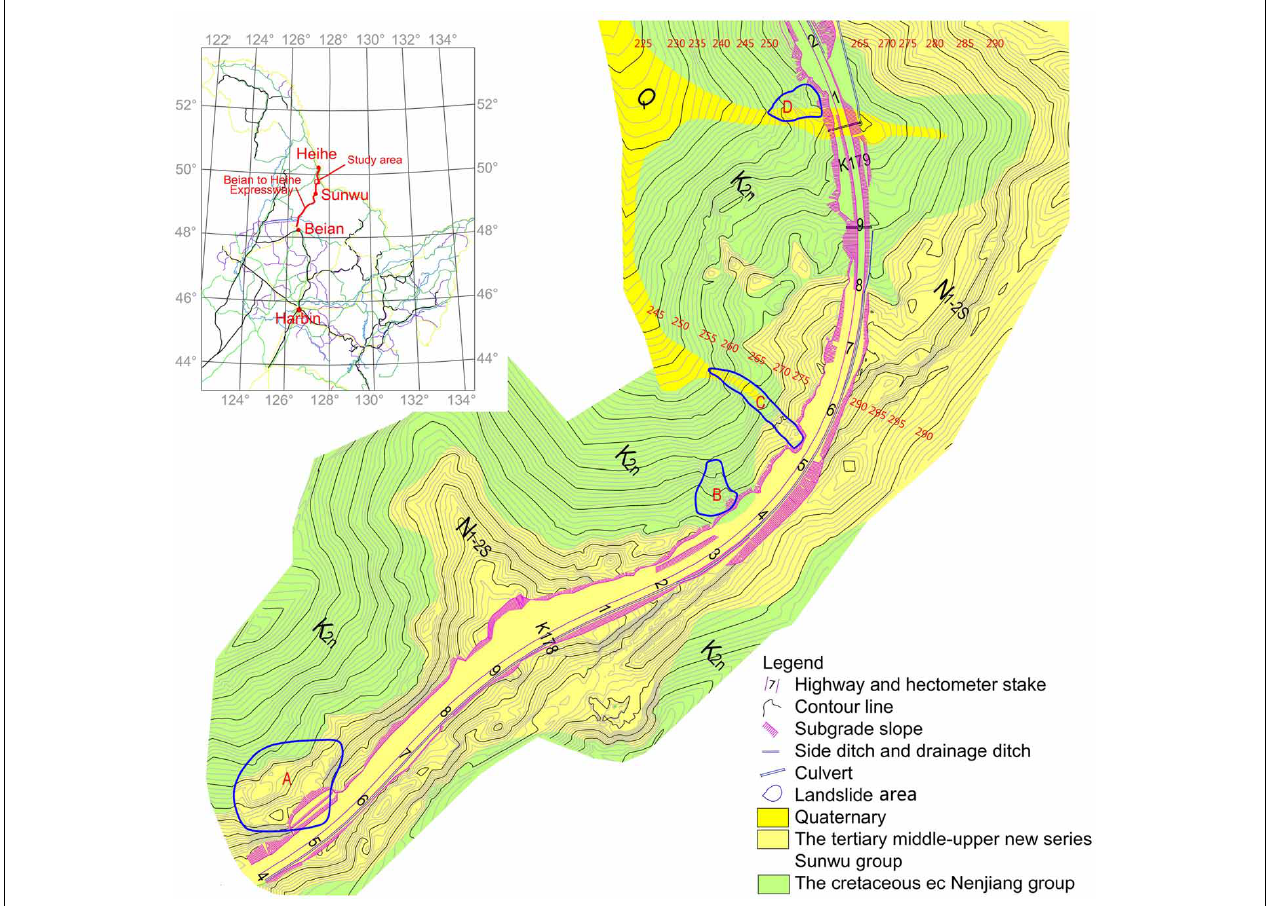
FIGURE 2 | Geological map of K177 + 400-K179 + 200 section of Bei’an-Heihe Highway.